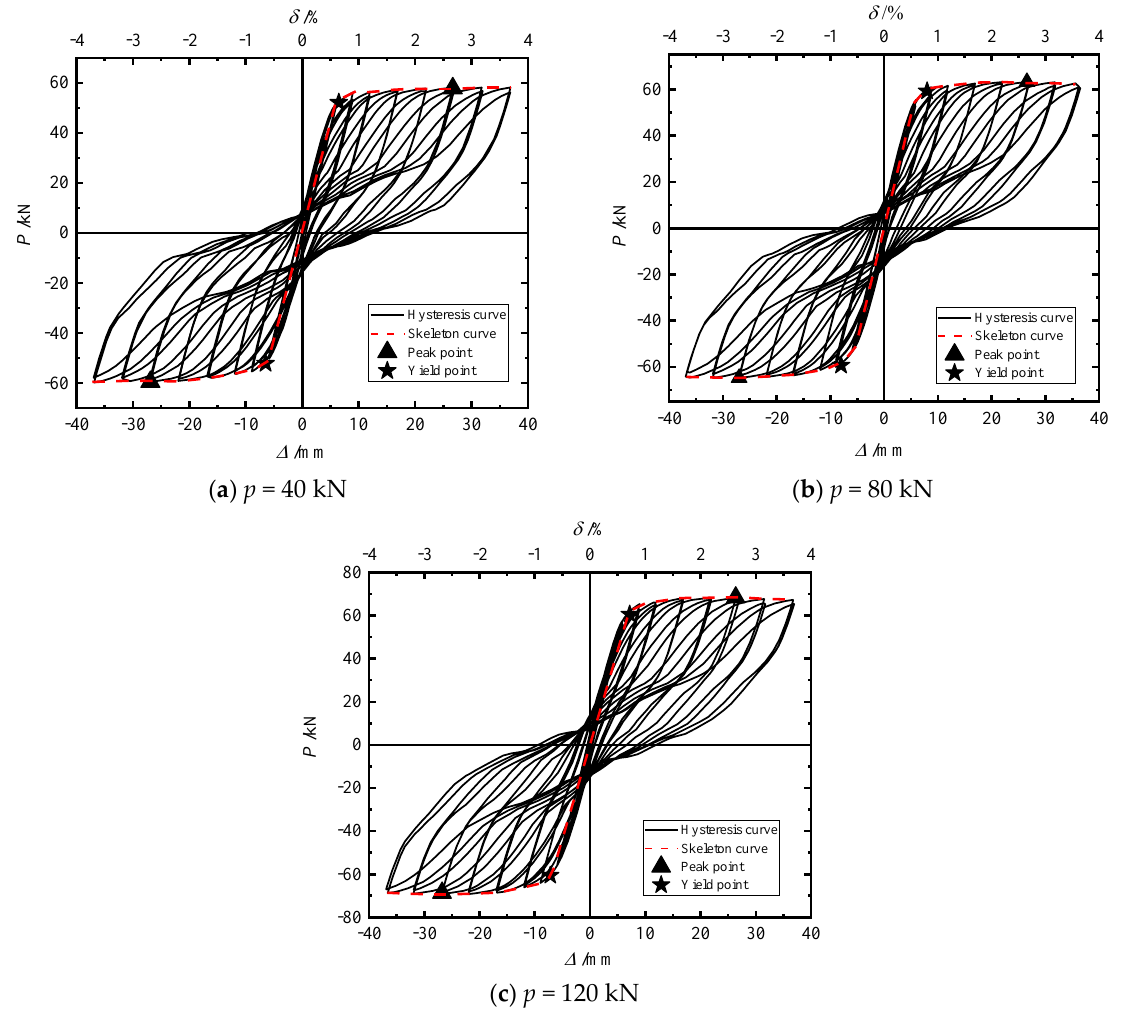
Figure 16. Residual displacement.